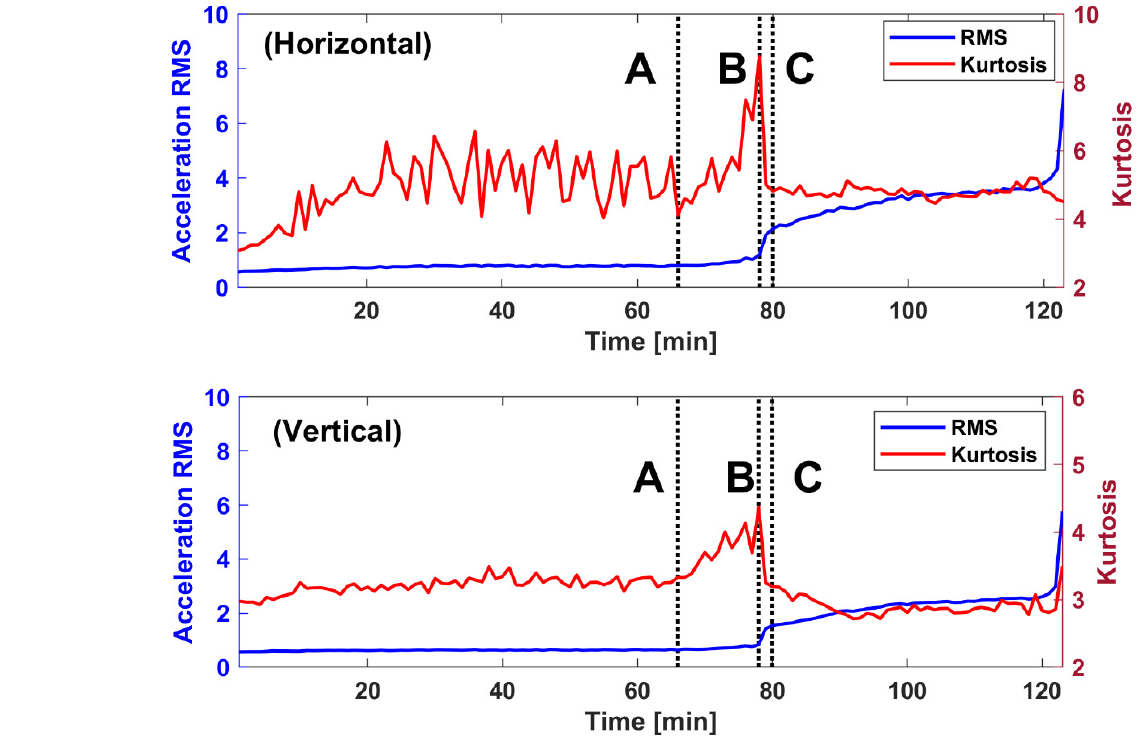
Figure 2. Trends of the overall bearing vibration by the acceleration RMS values and Kurtosis: ( a ) the horizontal-channel vibration and ( b ) the vertical-channel vibration.